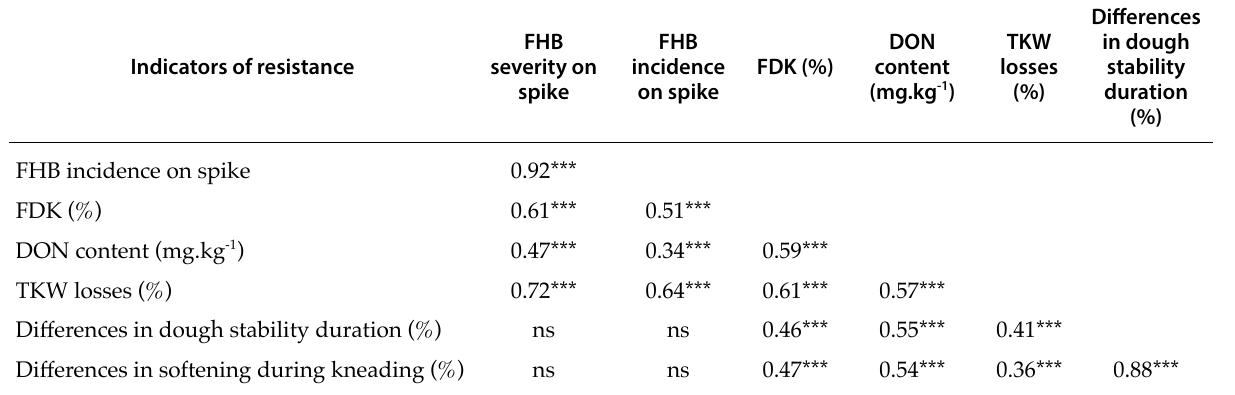
Table 7. Pearson correlation coefficients between observed indicators of resistance and relative differences in grain rheo - logical properties caused by Fusarium inoculations. *** significant at P =0.001, ns = not significant ( P >0.05).